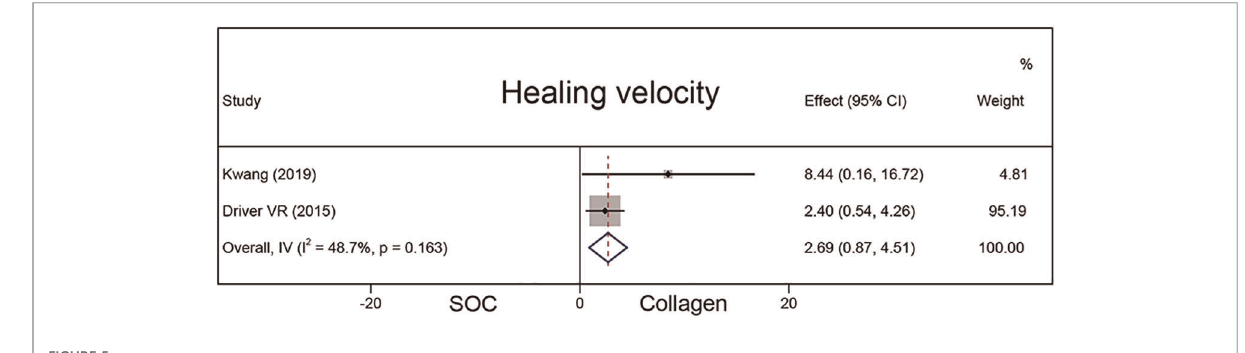
FIGURE 5 The pooled result of healing